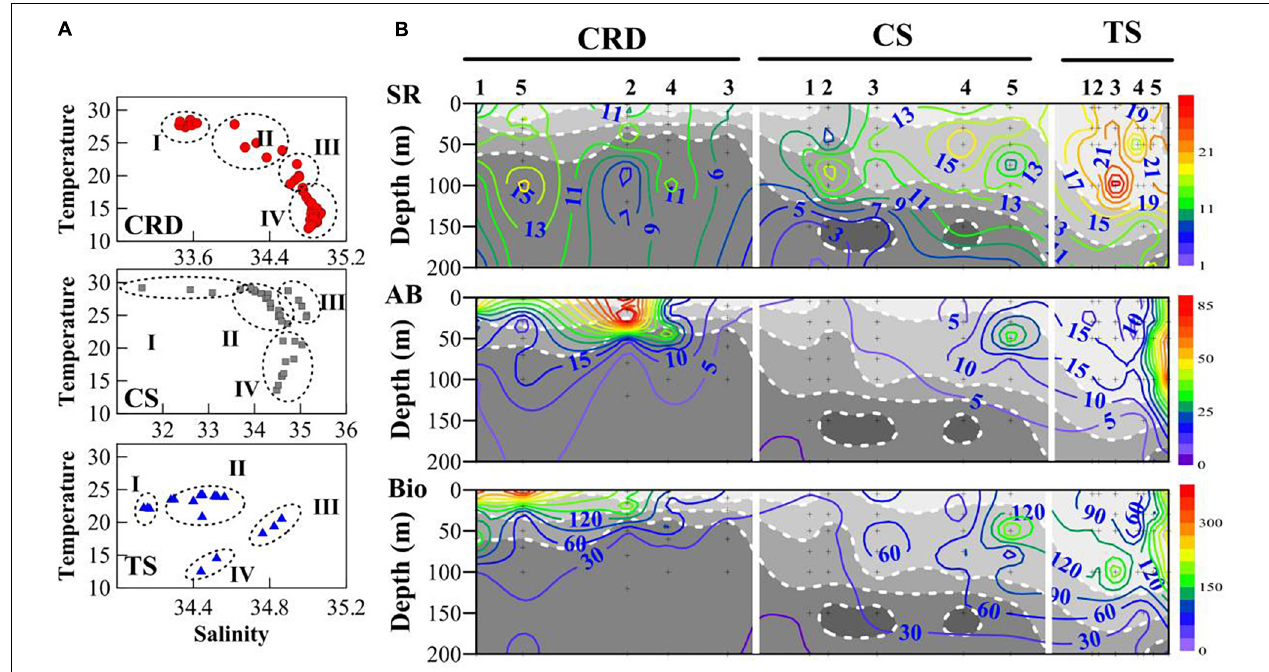
FIGURE 2 | (A) Different water masses were identified from temperature-salinity diagrams with consideration of cluster analysis for the three investigated regions: CRD, CS, and TS, I–IV indicates four water masses in each of the three investigated regions. (B) Vertical distribution of species richness (SR), abundance (AB, × 10 3 ind m − 3 ), and biomass (Bio, µ g m − 3 ) of tintinnid assemblages. White dotted lines show limits between different water masses defined in Panel (A)